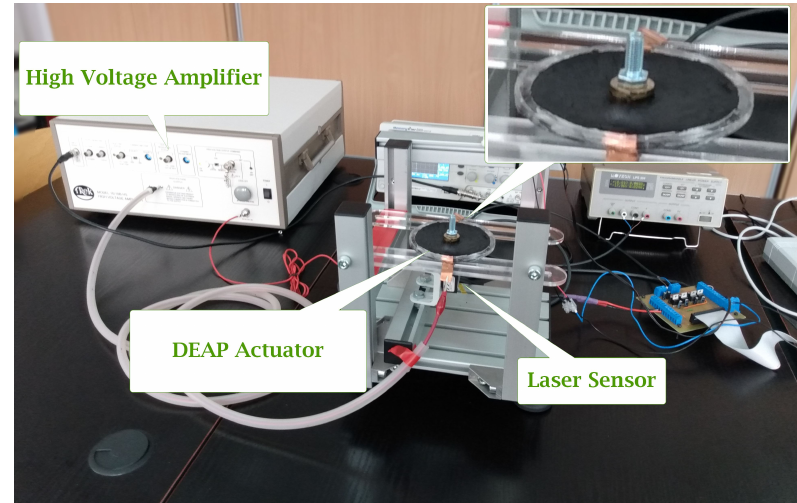
Figure 6. The laboratory setup of DEAP actuator measurement. Table 1. Parameters of DEAP actuator